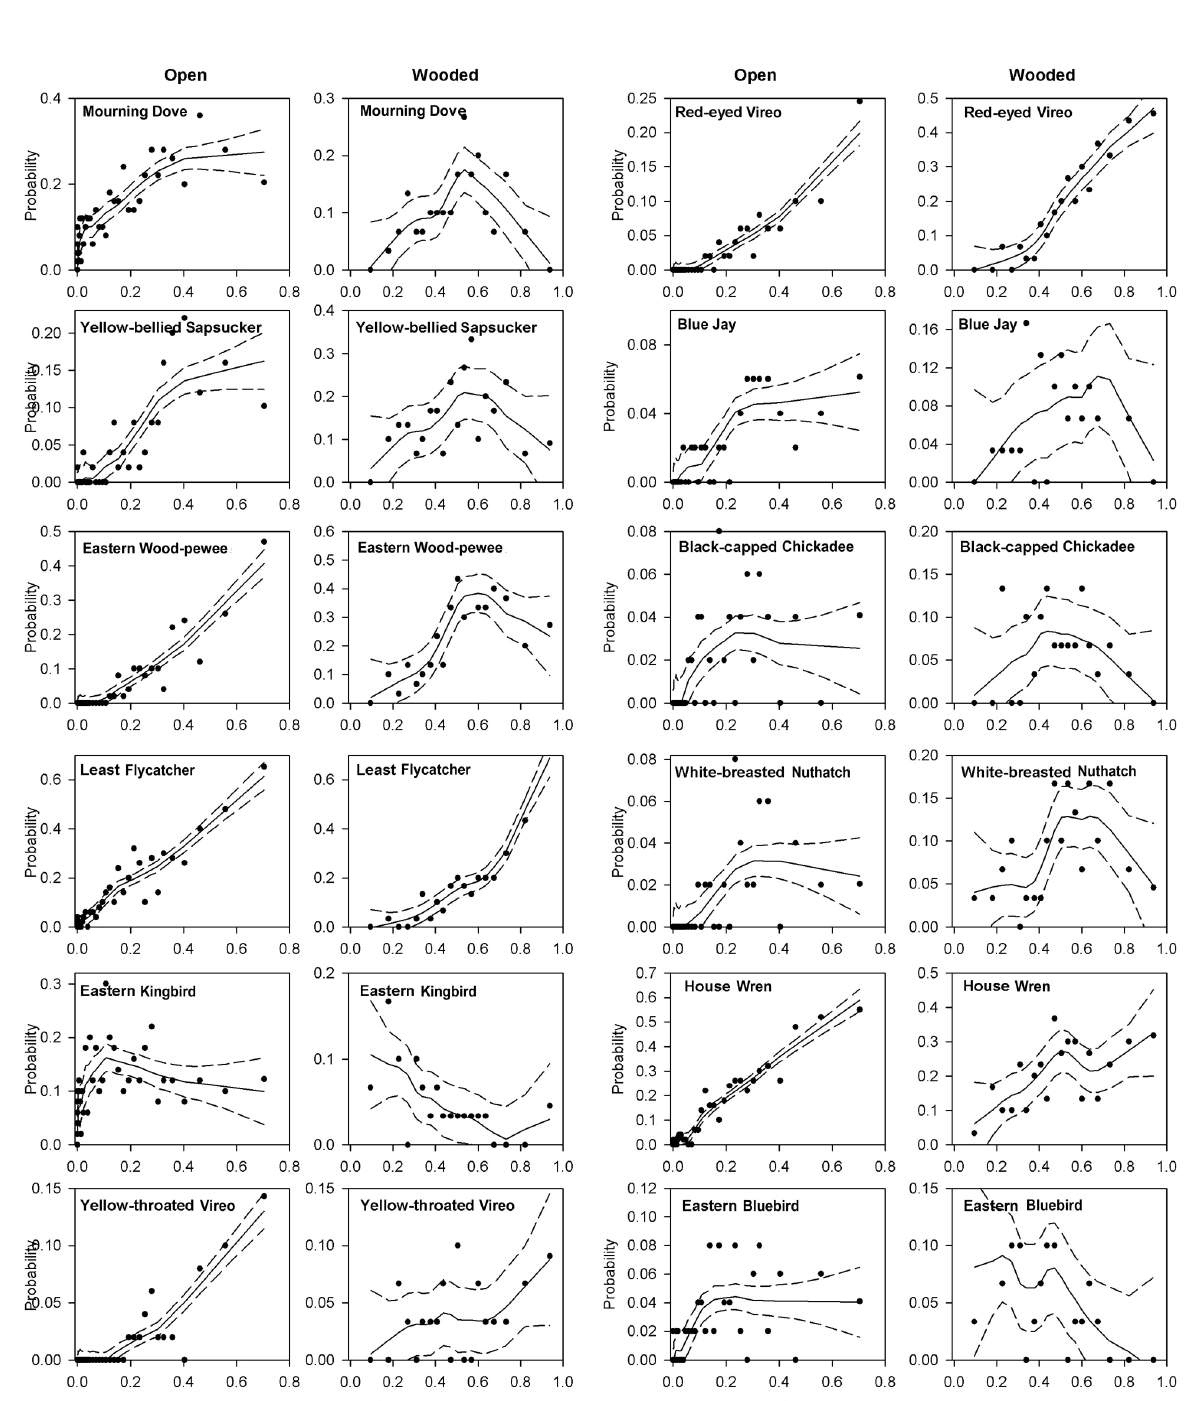
Fig. 4 . Comparison of responses (estimated probability of occurrence) to site-scale (100-m radius) tree cover in open landscapes and wooded landscapes. (Open landscapes were defined as < 30% tree cover within a 400-m radius; wooded landscapes had > 30% tree cover.) Lines show loess scatterplot smoothing and 95% confidence intervals for groups of observations (dots; see Methods). An upward linear pattern indicates a strong preference for more tree cover at the 100-m scale. A peaked pattern indicates selection for intermediate amounts of tree cover. For some species, proximate-scale responses in open and wooded landscapes differed, e.g., Mourning Dove ( Zenaida macroura ), weakened, e.g., House Wren ( Troglodytes aedon ), or even reversed, Eastern Kingbird ( Tyrannus tyrannus ). Twelve of the 22 species are shown (see Figure 5 for the remaining 10). For species’ scientific names, see Table